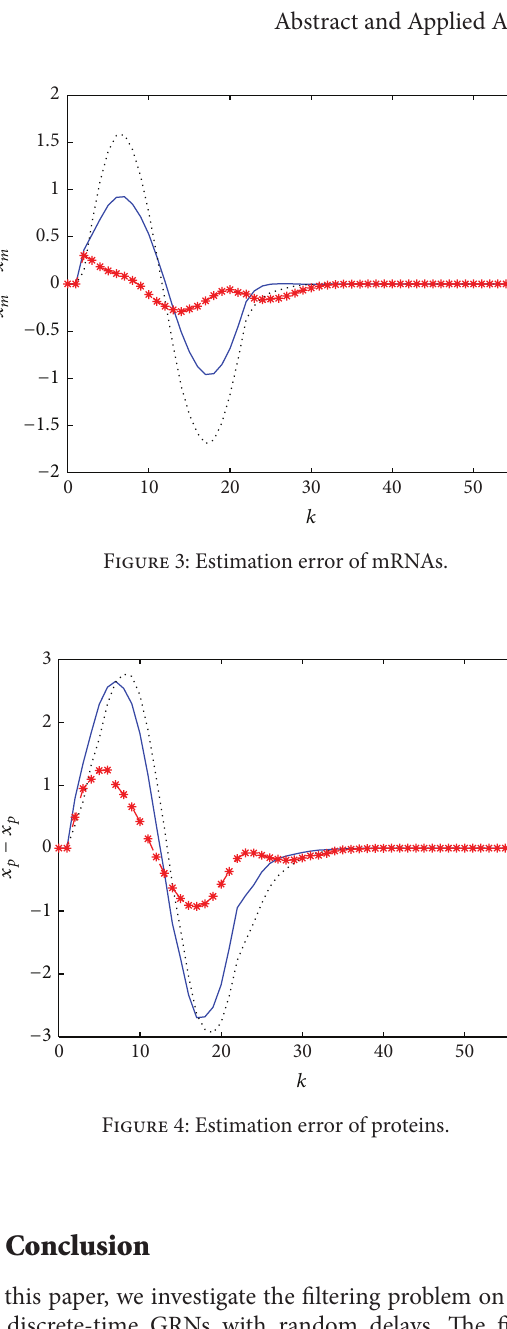
Figure 2: Trajectories and estimations of proteins.